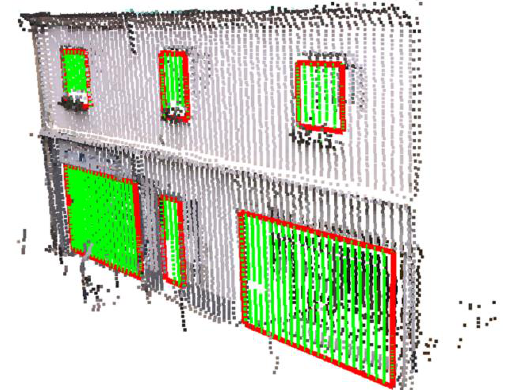
Figure 6: Green: opening points. Red: opening contours.